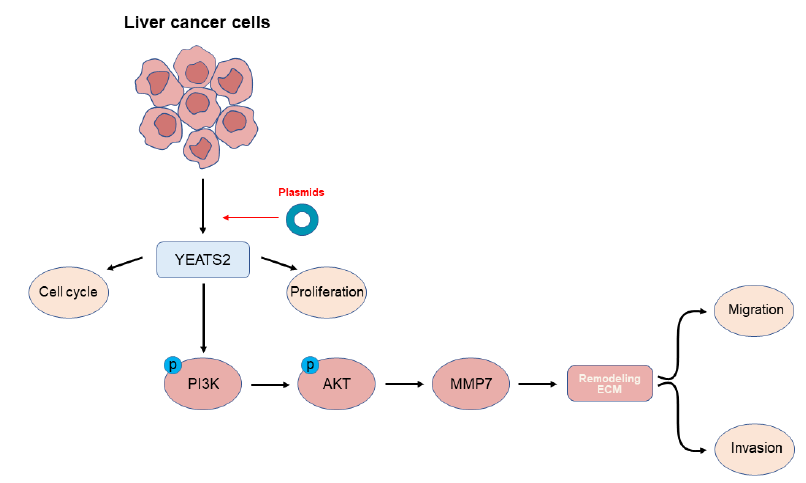
Figure 7. Overexpression of YEATS2 remodels ECM to promote Hepatocellular carcinoma progres- sion via the PI3K/AKT/MMP7 pathway.